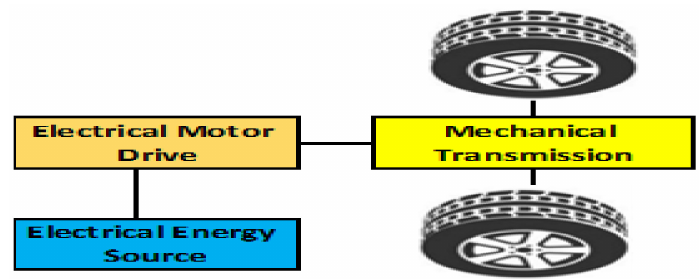
Figure 1. Basic structure of the electric vehicle power train